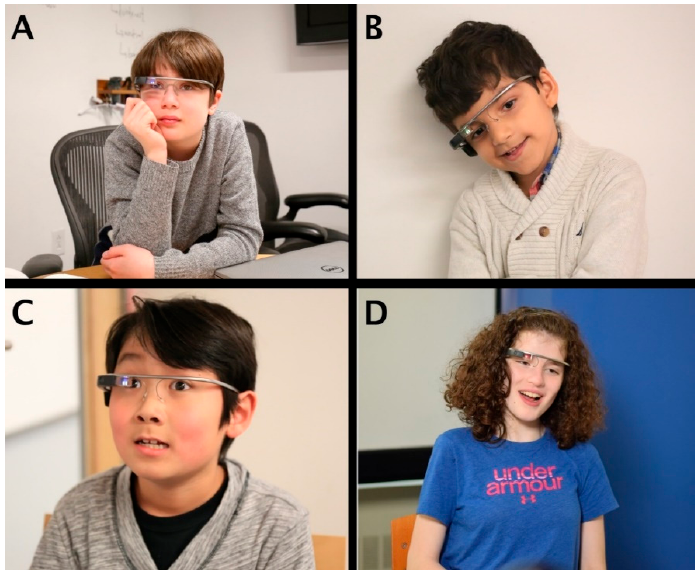
Figure 7. ( A – D ) Smartglasses Platform in Use. Four representative trial participants ( A – D ) wearing